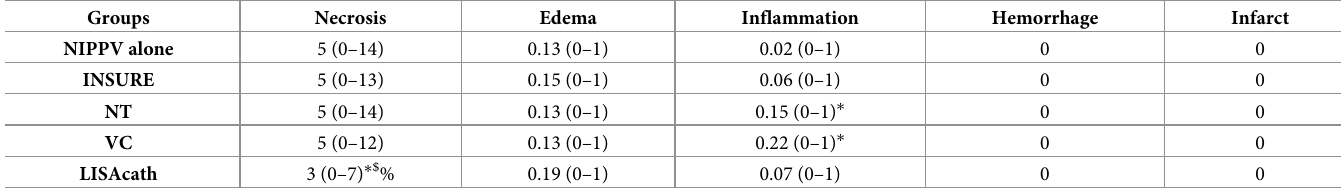
Table 4. Total brain injury scores. Groups Inflammation